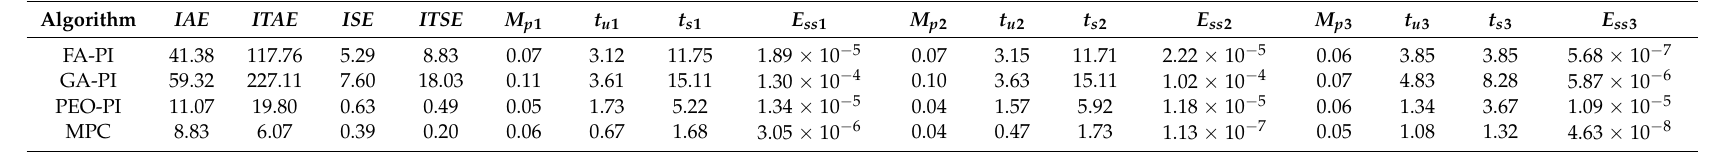
Table 4. Performance comparison of MPC, PEO-PI, GA-PI and FA-PI for case 1.